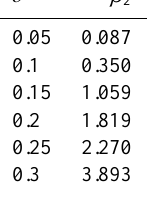
Figure 5. Simulation model.